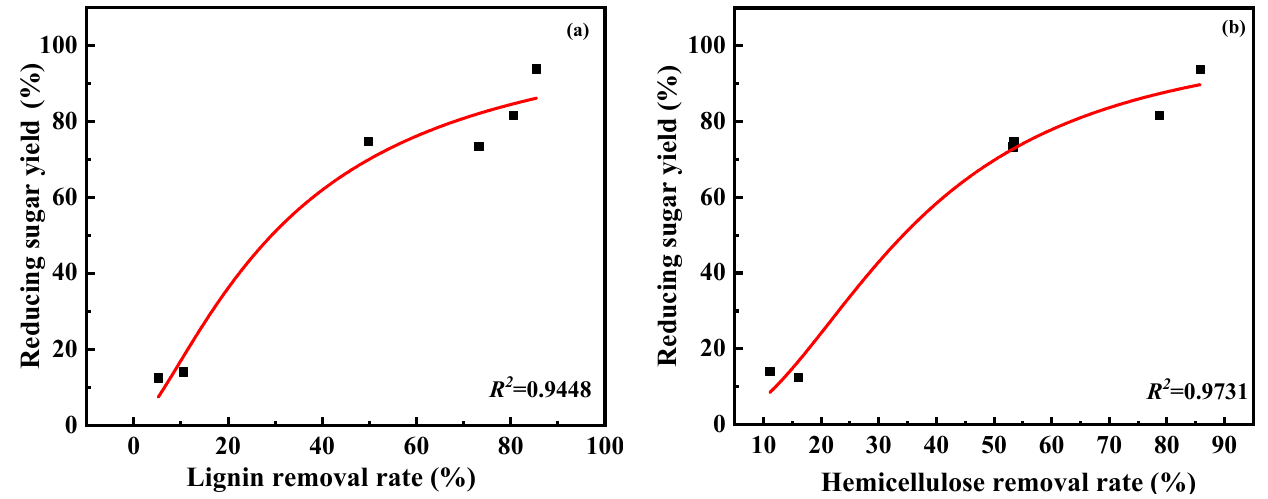
Figure 4. Correlation between reducing sugar yield and lignin removal rate ( a ) and hemicellulose removal rate ( b ).